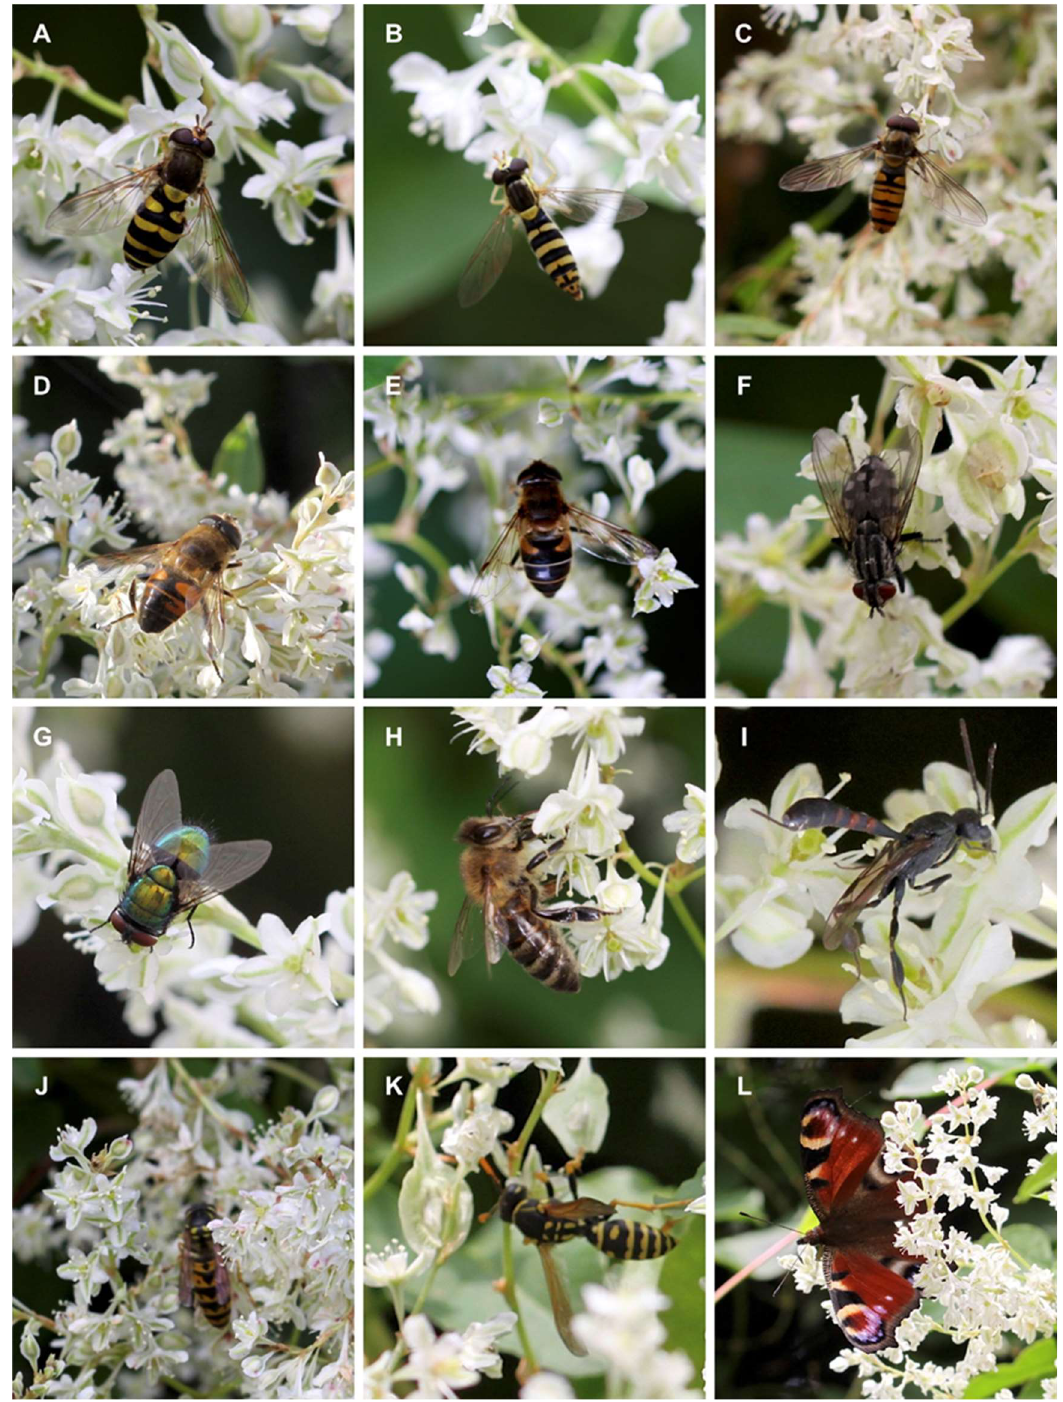
Figure 3. Pollinators and visitors of Fallopia baldschuanica (Polygonaceae) were observed in 2019–2020 in the center of Wrocław, SW Poland. ( A ) Syrphus ribesii , ( B ), Sphaerophoria scripta , ( C ) Episyrphus balteatus , ( D ) Eristalis tenax , ( E ) Eristalis pertinax , ( F ) Sarcophaga sp. ( G ) Lucilia sericata , ( H ) Apis mellifera , ( I ) Gasteruption assectator , ( J ) Vespula vulgaris , ( K ) Polistes dominula , and ( L ) Aglais io